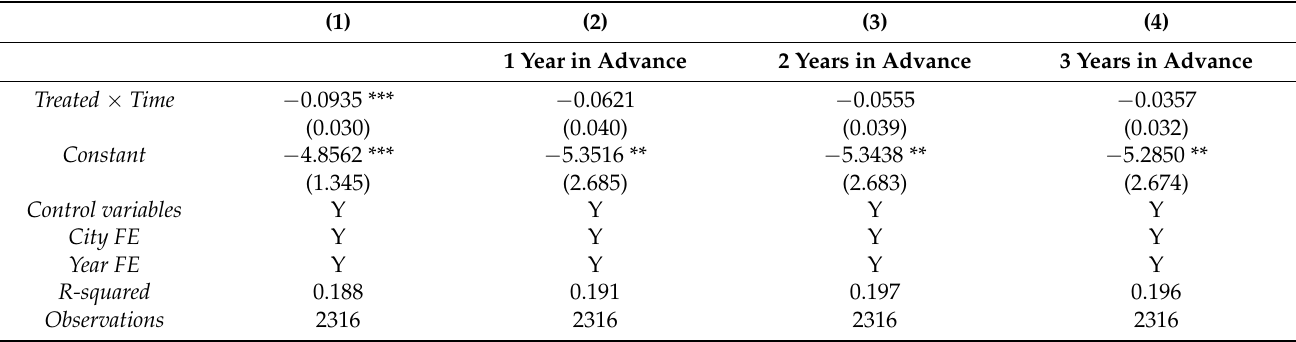
Table 5. Robustness test of changing the time of policy